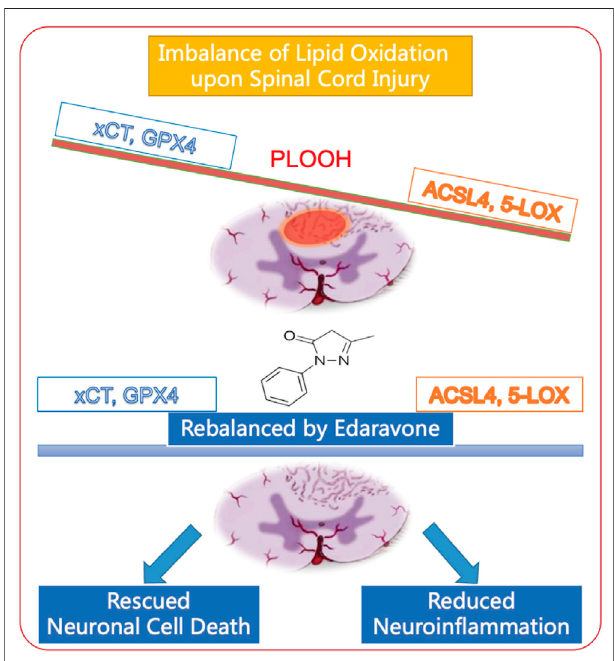
FIGURE 8 | Schematic diagram of edaravone ’ s neuroprotective mechanism in spinal cord injury. Edaravone upregulates anti-ferroptosis proteinGPX4andxCTanddownregulatespro-ferroptosisproteinACSL4and 5-LOX. This leads to neuronal survival as well as reduced neuroin fl ammation, and improves recovery of